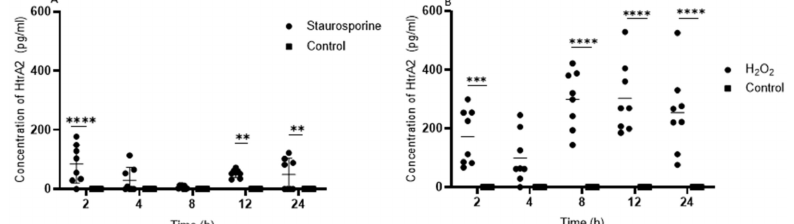
Figure 1. ( A ) High-temperature-required protein A2 (HtrA2) is found after staurosporine induction of apoptosis in the supernatant of human umbilical vein endothelial cells (HUVECs). ( B ) HtrA2 is significantly increased in the supernatant of HUVECs after H 2 O 2 -induced necrosis. Data is presented as dot plots with means and Standard Deviation(S.D). Significantly di ff erent vs. corresponding control with **** p < 0.0001, *** p < 0.001 and ** p <